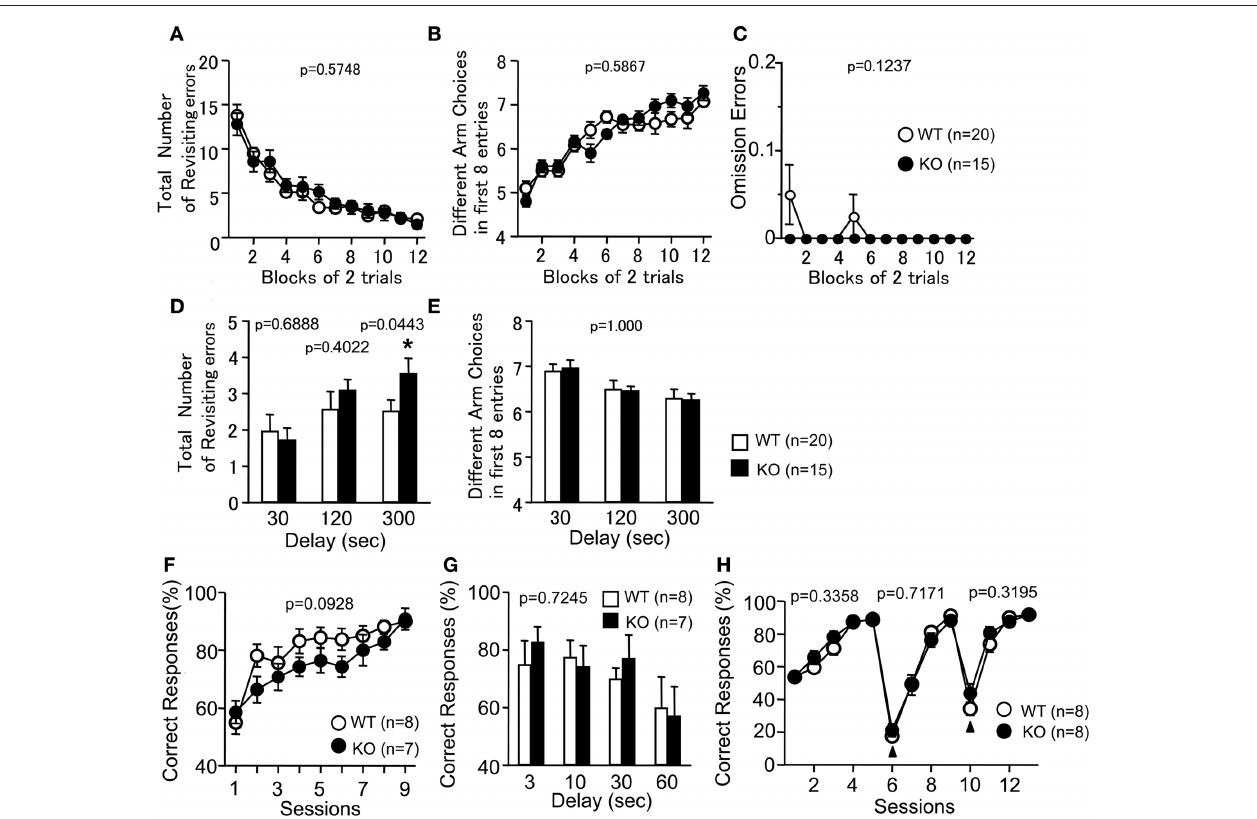
FIGURE 6 | Working memory performance of PACAP KO mice. Radial Maze: Total number of arms revisited (A,D) , different arm choices among the first eight entries (B,E) , and omission errors (C) during training were shown. During trials 25–30, a delay was applied after the first four pellets were consumed (D,E) . Data are presented as means of two trials. (F,G) Forced alternation task: the percentage of correct choices was shown.